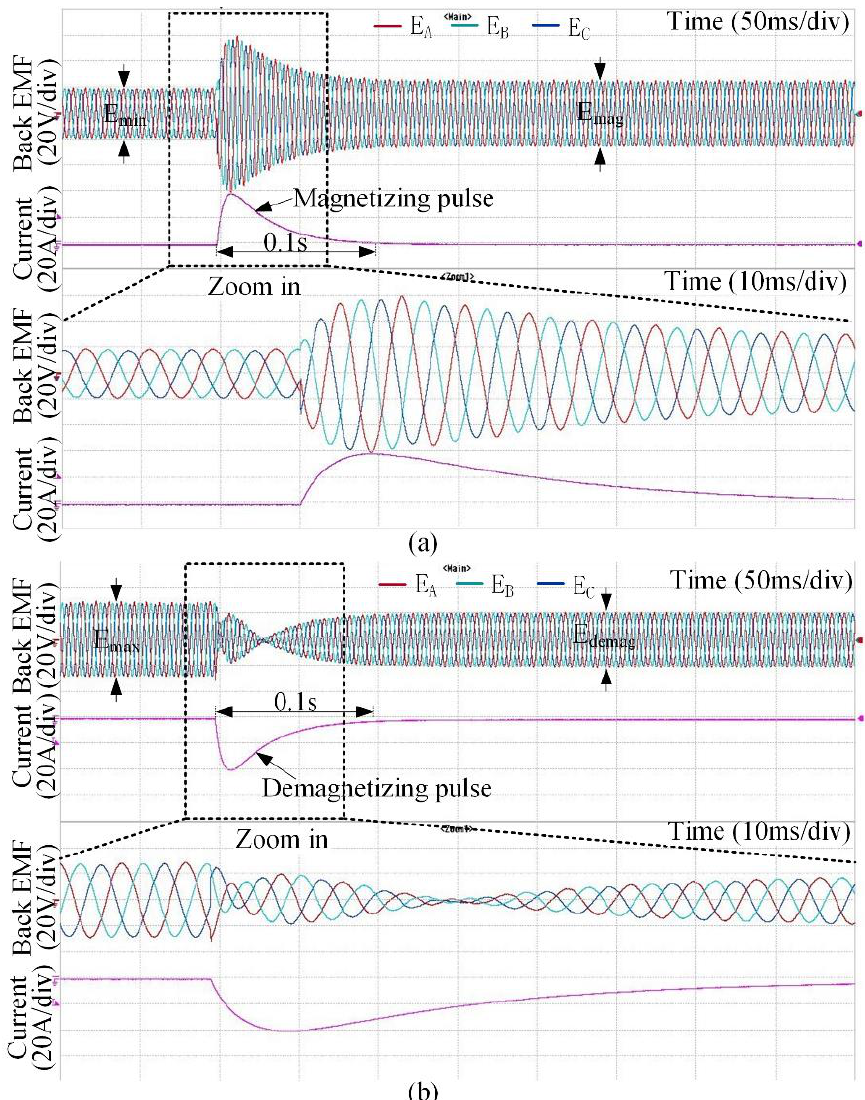
Figure 21. Measured transient response of back-EMFs under a short duration of current impulse at the rated speed: ( a ) magnetizing process; ( b ) demagnetizing process.